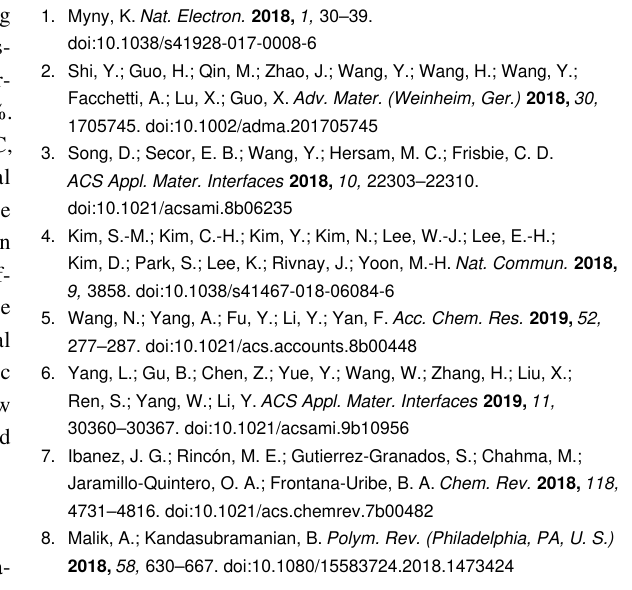
the horizontal deviations are about 3.52 μ m. The composite template (83.8 wt %) prepared via dry blending yields a